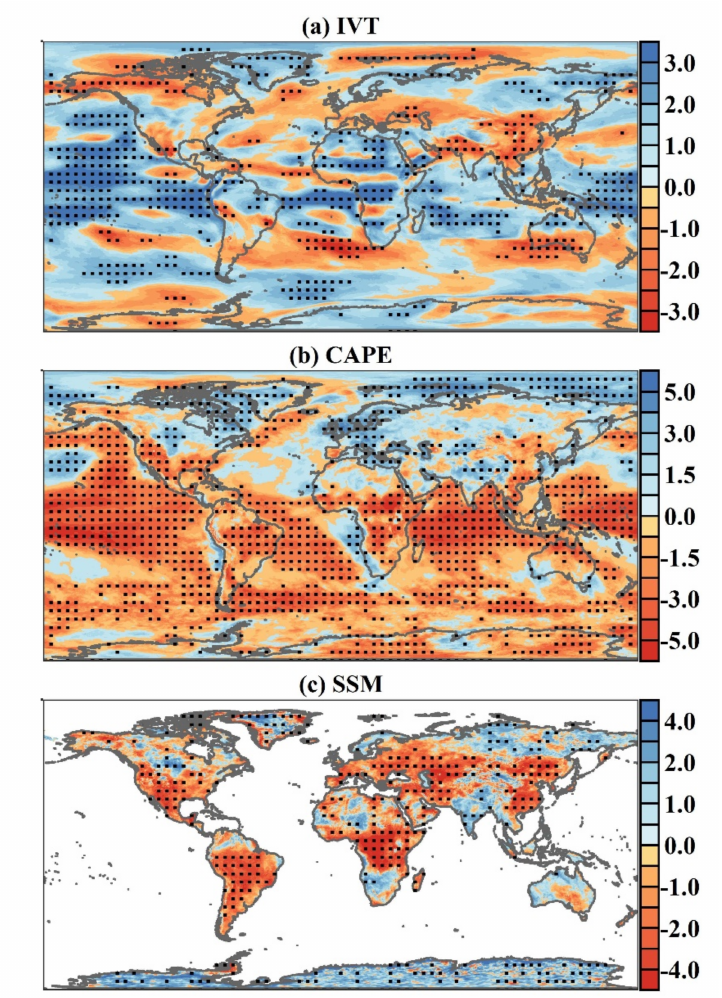
Figure 10. Spatial distributions of long-term changes of integrated vapor transport (IVT; units: kg m − 1 s − 1 ; ( a ), annual convective available potential energy (CAPE; units: J g − 1 ; ( b ), and surface soil moisture (SSM; m 3 m − 3 ; ( c ) in 0.25 ◦ × 0.25 ◦ grids during 1979–2012. The black dots indicate the grid with significant changes (i.e., p ≤